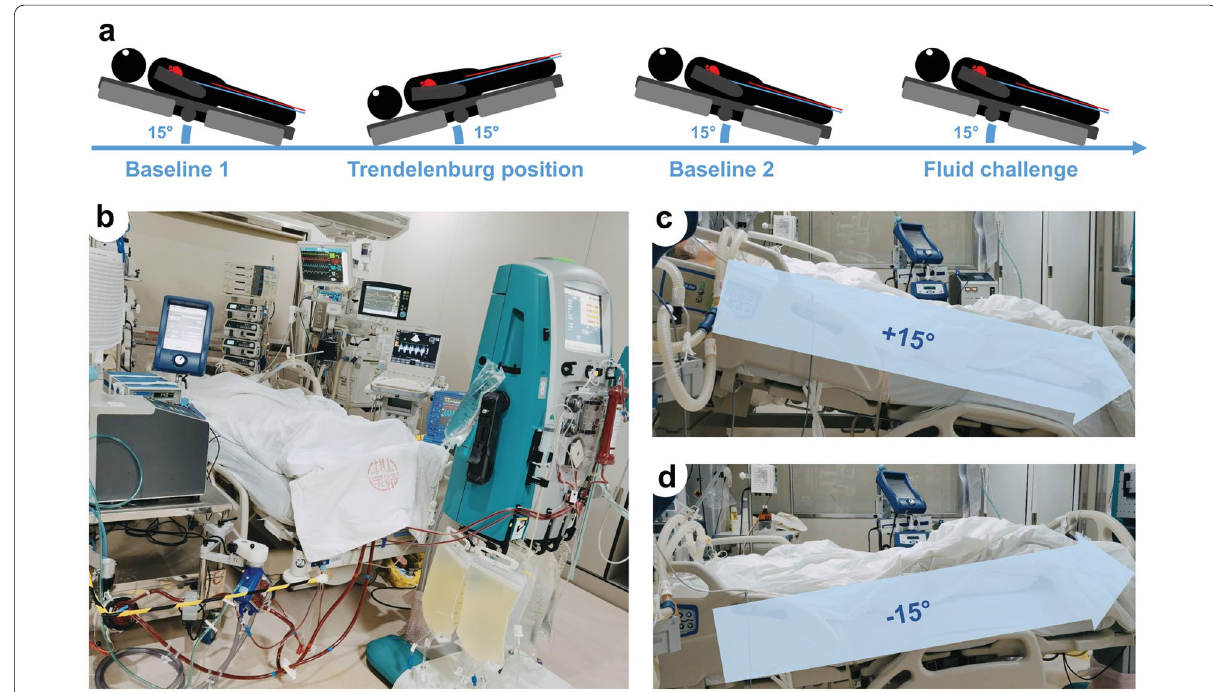
Fig. 1 The study protocols. a An outline of each step; b a clinical scenery of VA‑ECMO patient; c the 15° upward bed angulation for measurements at baselines and fluid challenge . d The 15° downward bed angulation for measurements in the Trendelenburg